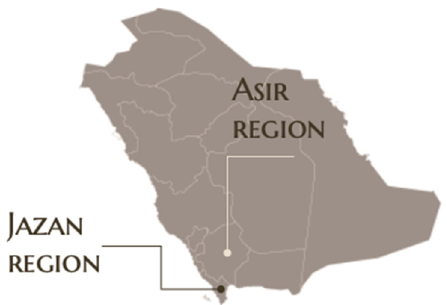
Figure 1. Map of Asir and Jazan regions at the southwestern region of Saudi Arabia. Thirty-seven samples were collected from Asir region and twenty-one from Jazan region.